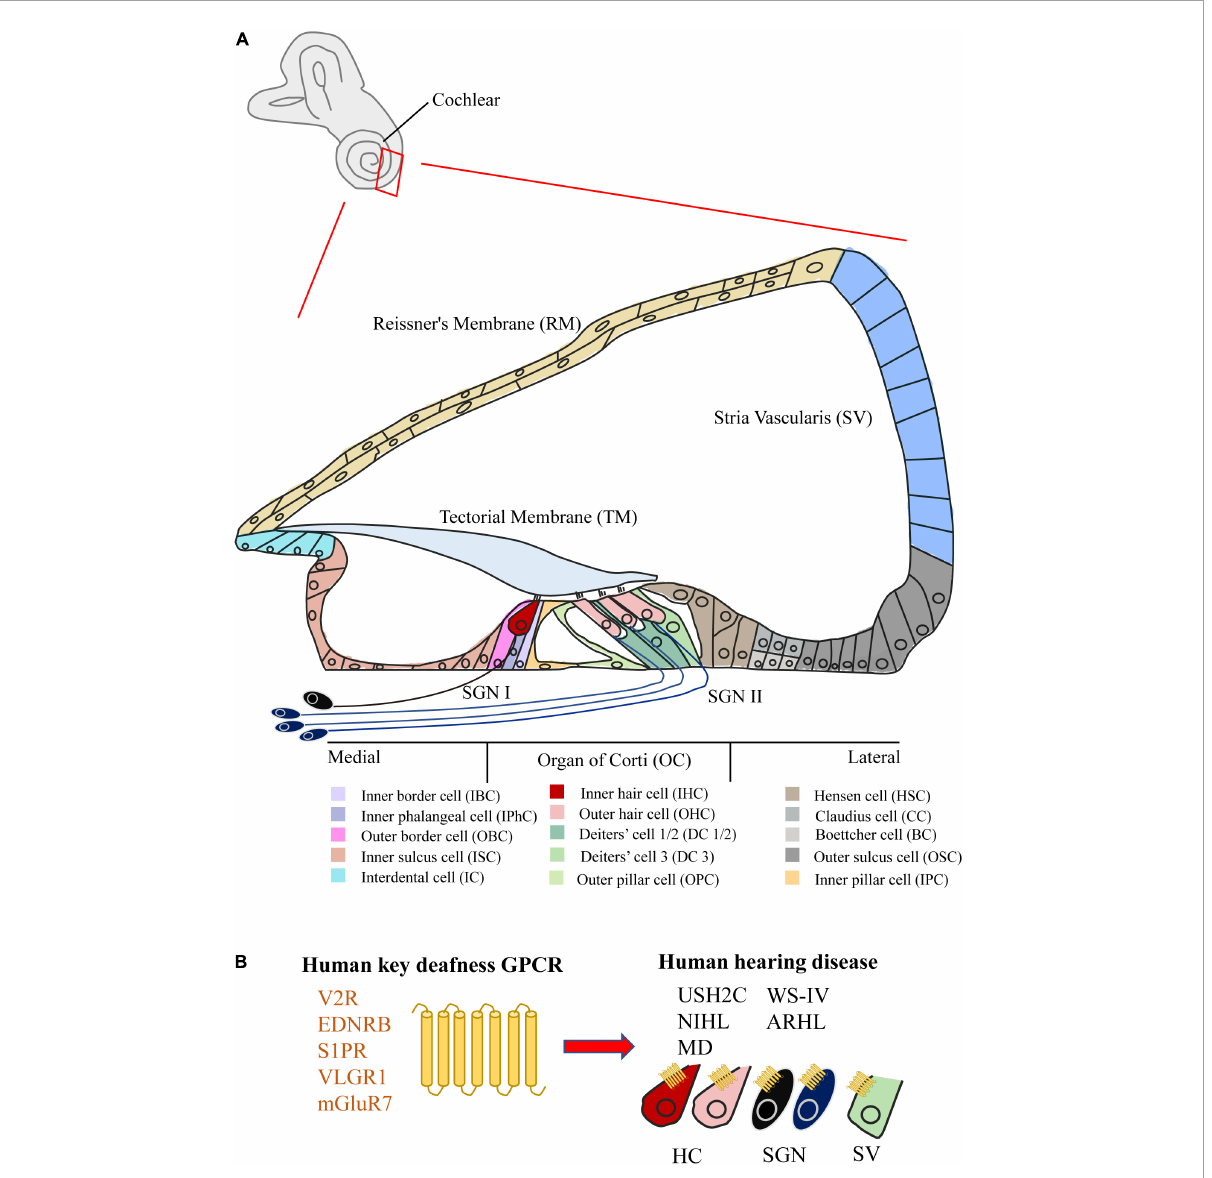
FIGURE1 Structure of the cochlea and the GPCR related to human hearing disease. (A) Schematic of the mammalian mature cochlea (cross-section). The cochlea can be divided into five parts, including Organ of Corti (OC), Stria Vascularis (SV), Reissner’s Membrane (RM), Spiral Ganglion Neurons (SGNs), Bony Labyrinth (BL) (not shown), and Mesenchymal Cell (MC) (not shown). Among them, two kinds of hair cell (HC) and various kinds of supporting cell (SC) can be subdivided in OC. (B) The summary of five key GPCRs (V2R, EDNRB, S1PR, VLGR1, and mGluR7) in cochlea related to human hearing disease (USH2C, WS-IV, NIHL, ARHL, and